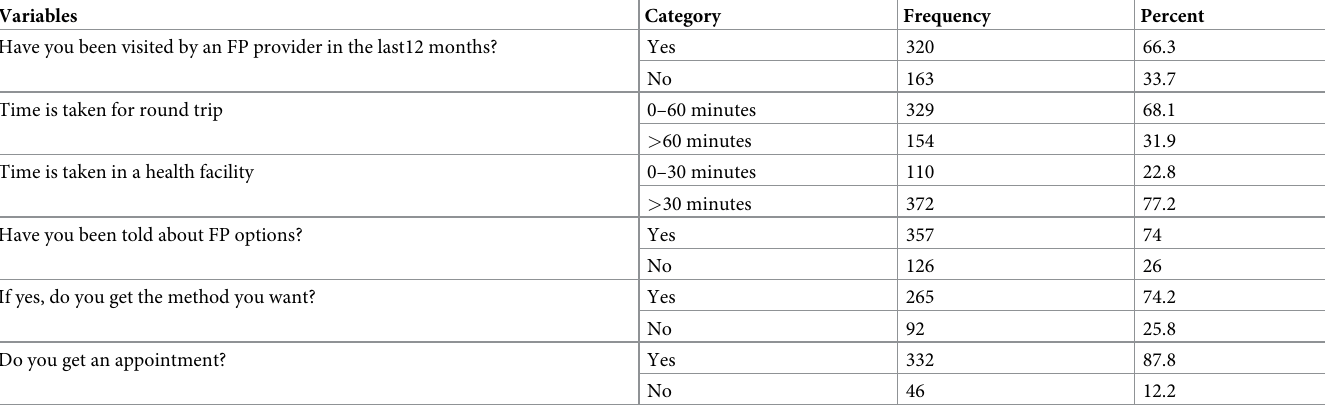
Table 4. Health facility and health workers related factors for unmet needs of modern family planning methods in South Gondar, Ethiopia, 2017 (n = 483).